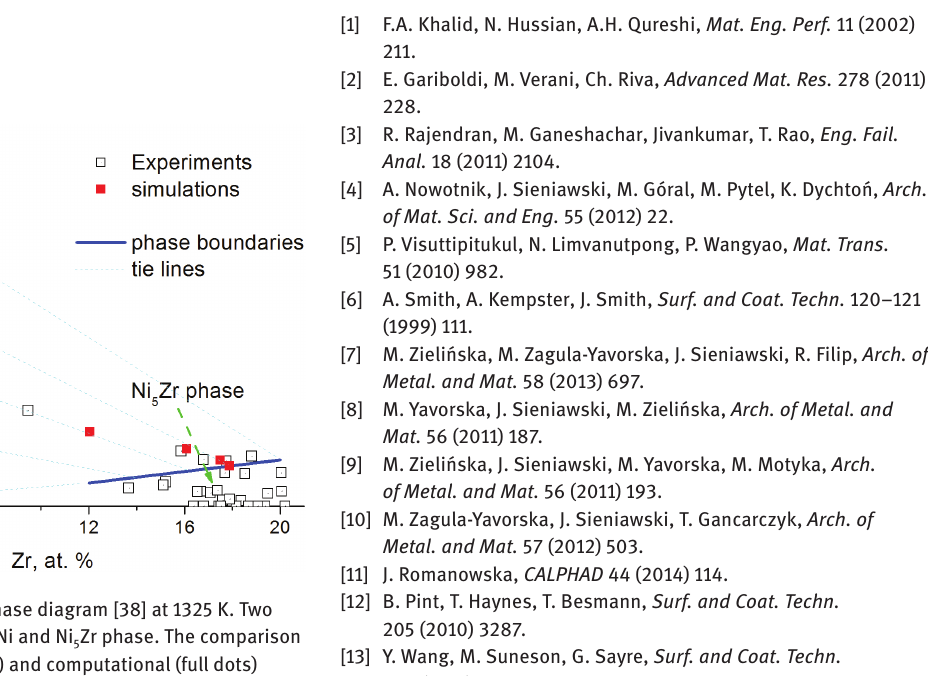
Fig. 8: The comparison of the concentration profile of the NiAlZr multiphase diffusion experiments (dots) and simulations (line).